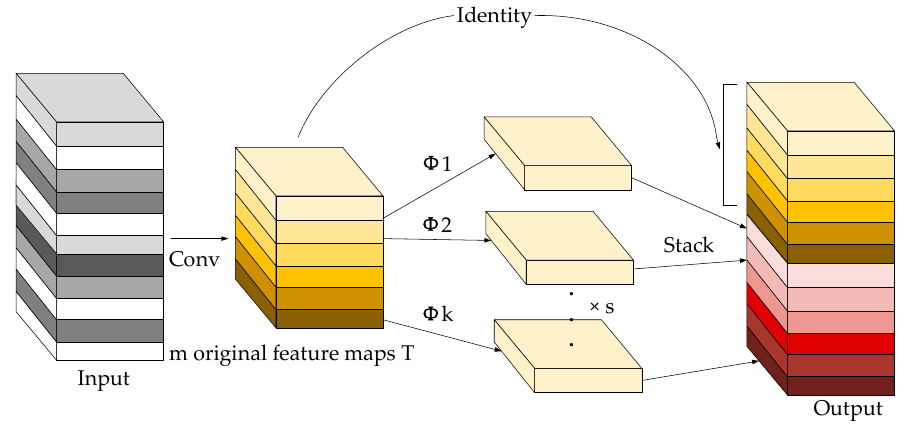
Figure 4. Ghost Module.